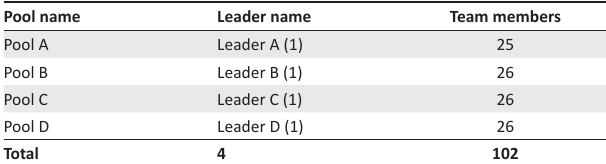
TABLE 1: Realised sample